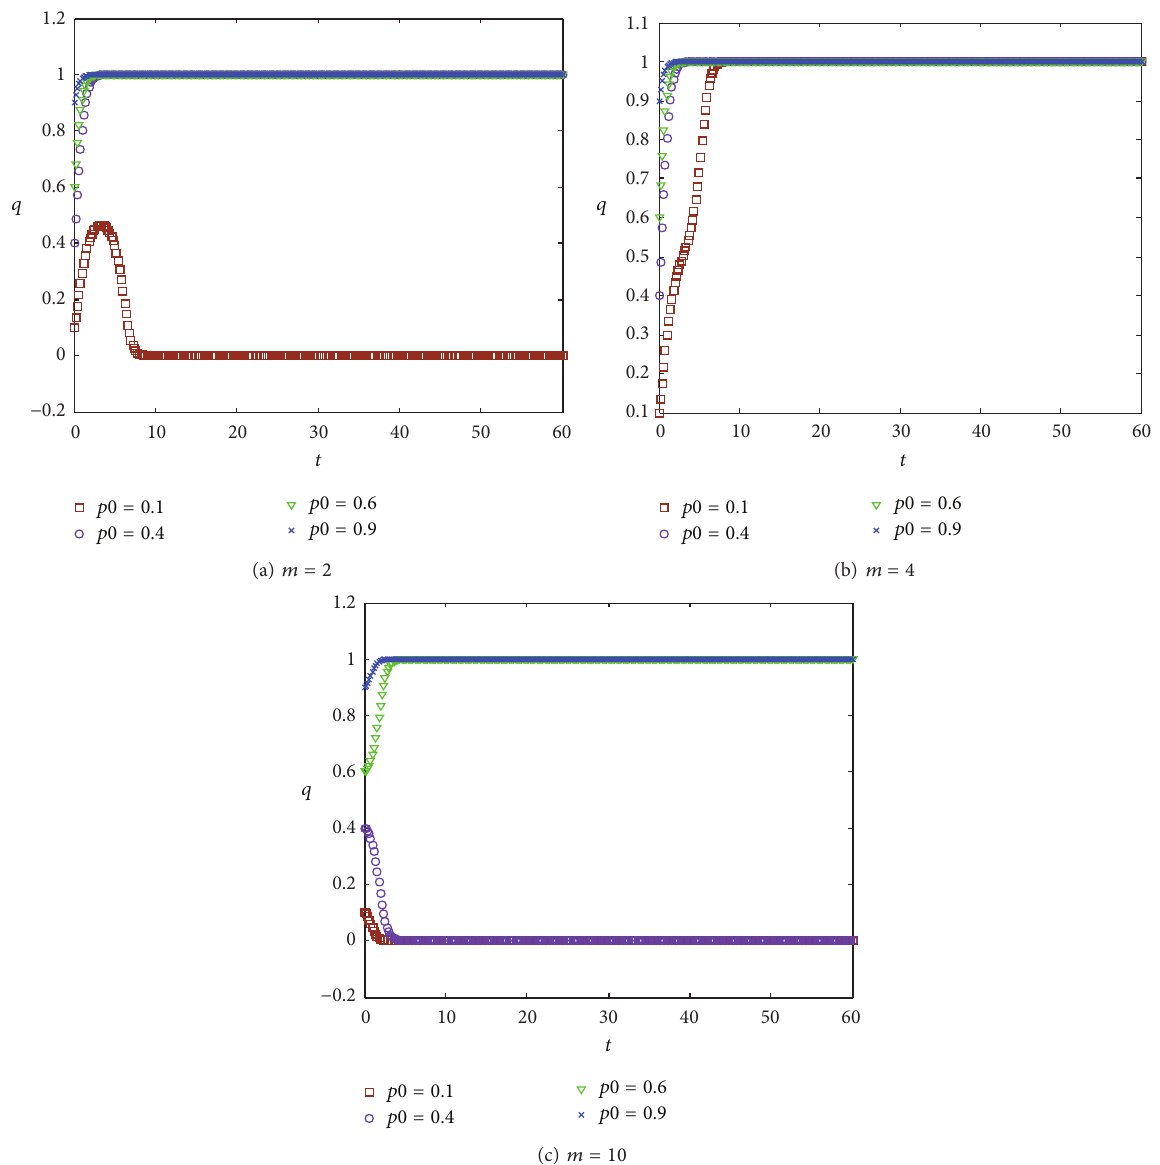
Figure 6: The influence of the punishing dynamics of government on the cooperation